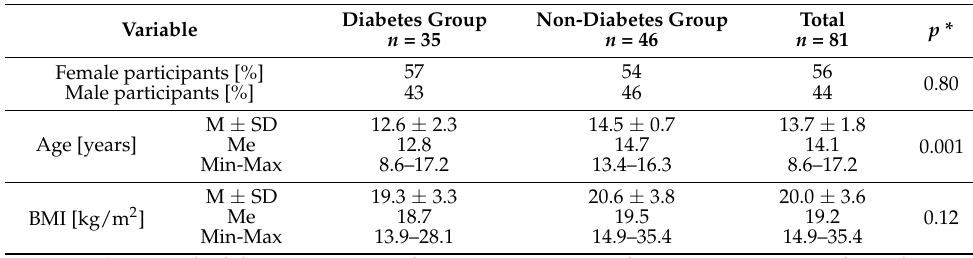
Table 2. Characteristics of the study group.